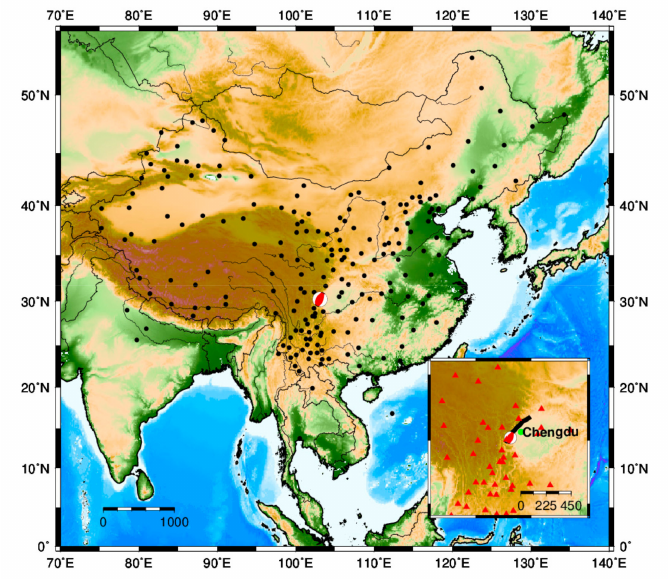
Figure 1. Distribution of the Crustal Movement Observation Network of China (CMONOC) GPS continuous tracking stations near the epicenter (small panel) and over China, where the focal sphere represents the epicenter, and black or red points represent the GPS